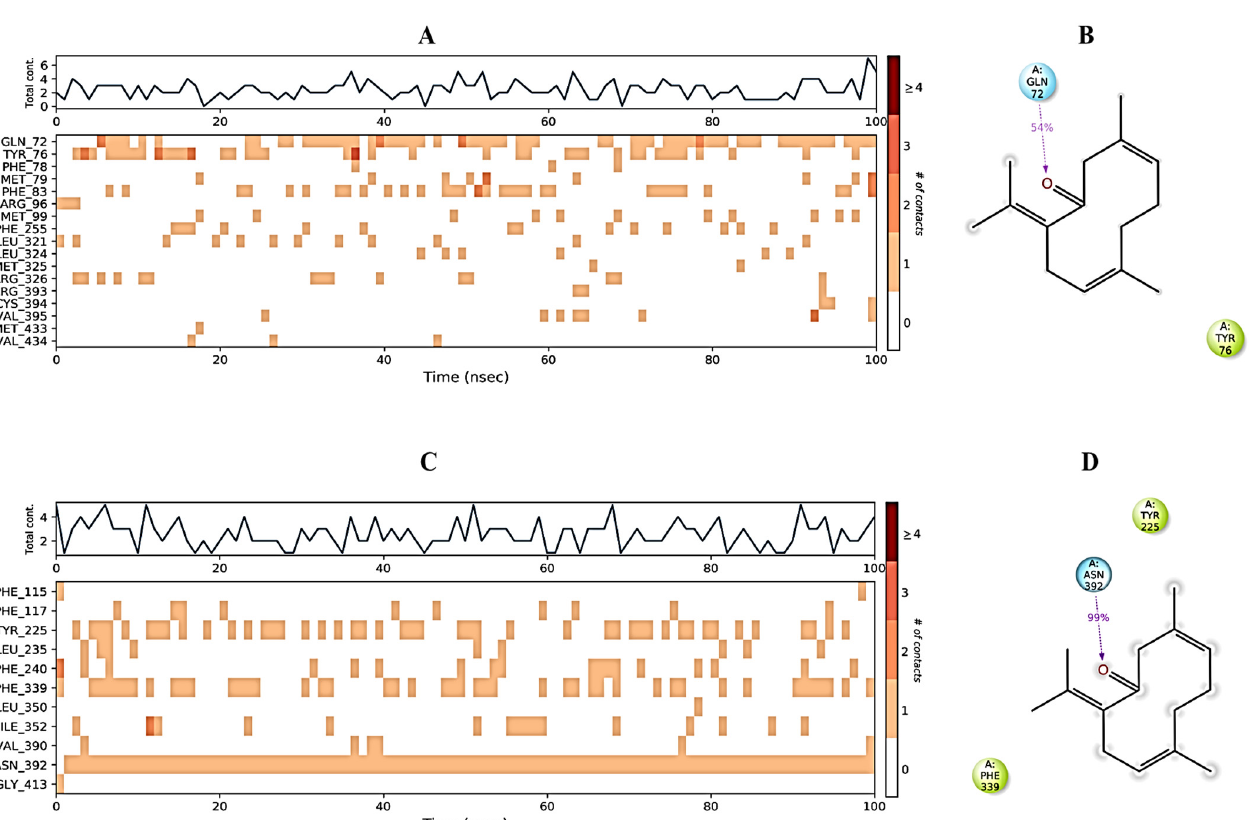
Figure 6. Histogram of ligand contacts with amino acid residues of target proteins. ( A ) 3,7-Cyclodecadien-1-one, 3,7-dimethyl-10-(1-methylethylidene) in complex with 1EA1; ( B ) 3,7-cyclodecadien-1-one, 3,7-dimethyl-10-(1-methylethylidene) in complex with 1IYL; ( C ): 3,7-cyclodecadien-1-one, 3,7-dimethyl-10-(1-methylethylidene) in complex with 1HD2; ( D ) 3,7-cyclodecadien-1-one, 3,7-dimethyl-10-(1-methylethylidene) in complex with 1HNY protein. Different types of bar color indicate different types of bonds: hydrogen bond (green), hydrophobic contacts (purple), and water-bridge (blue).